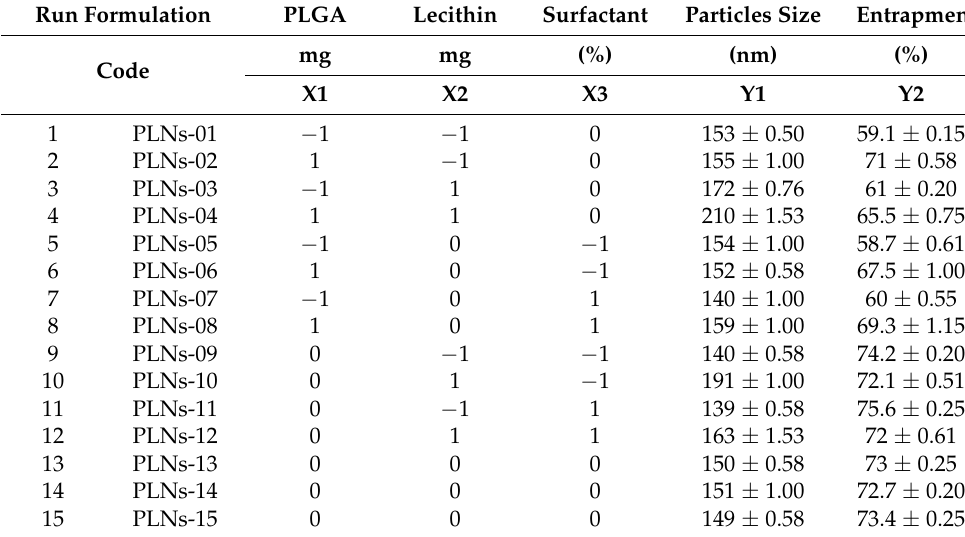
Table 3. Box–Behnken design with measured responses.